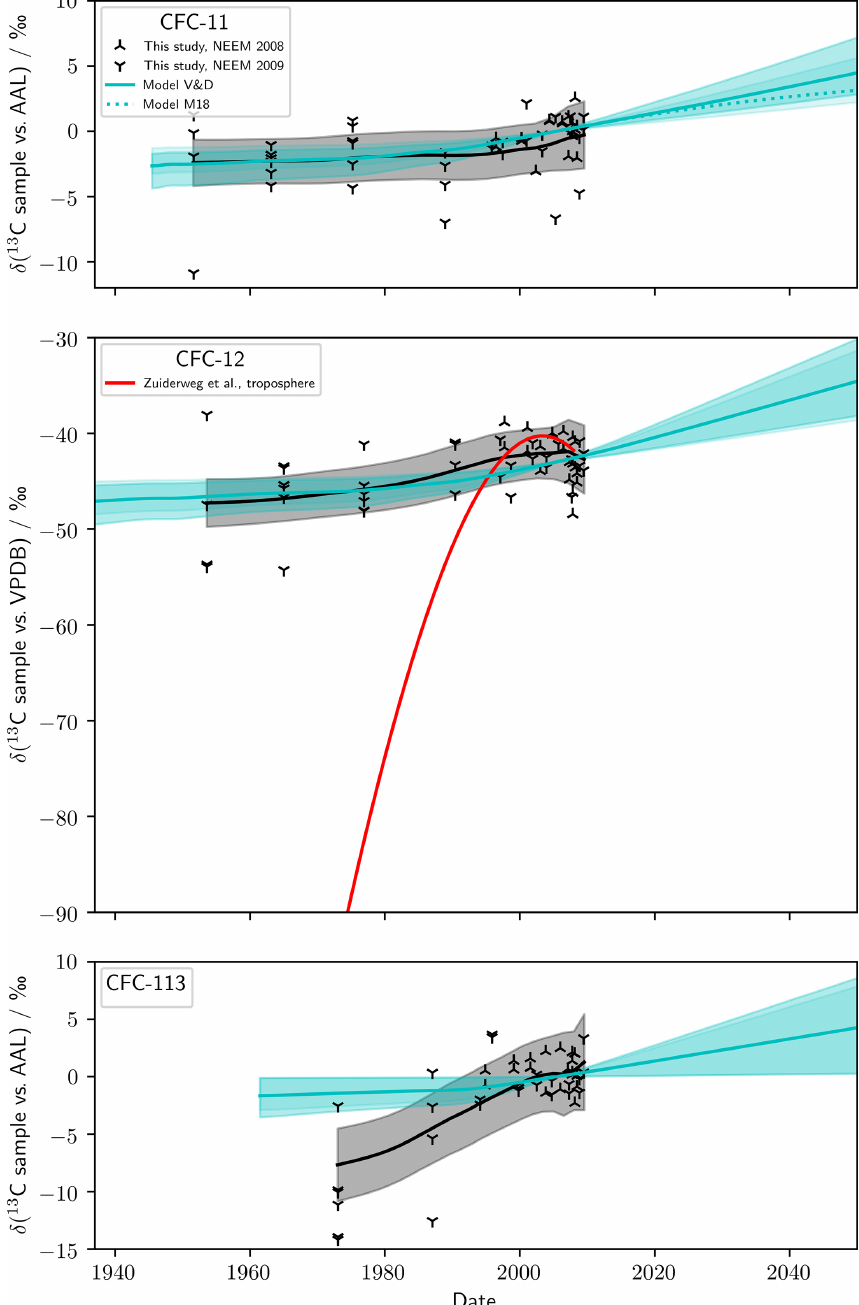
Figure 4. Measured and modelled δ T ( 13 C, CFC-11), δ T ( 13 C, CFC-12), and δ T ( 13 C, CFC-113). The smoothed trend and 95% confidence intervals for measured δ T ( 13 C) are shown by the solid black line and grey shading, respectively. The solid blue line shows the mean modelled δ T ( 13 C) for the Velders and Daniel (2014) scenario (V&D) and the two stratosphere–troposphere exchange parameterisations (Holton, 1990; Appenzeller et al., 1996). (cid:15) app (high-latitude) was used for each CFC. Blue shading shows the 95% uncertainty envelope for the Holton (1990) and Appenzeller et al. (1996) parameterisations. For CFC-11 only, the dotted blue line shows the mean modelled δ T ( 13 C) for the M18 scenario, with the uncertainty envelope omitted for clarity. For CFC-12, the red line shows δ T ( 13 C) as predicted by Zuiderweg et al. (2013) (amending a typo in the coefficients presented by Zuiderweg et al. (2013), δ T ( 13 C, CFC-12) = − 265 . 4280 + 4 . 8315 x + ( 7 . 8555 × 10 − 5 )x 2 − ( 3 . 3070 × 10 − 4 )x 3 , where x = t − 1933 . 5, and t gives the